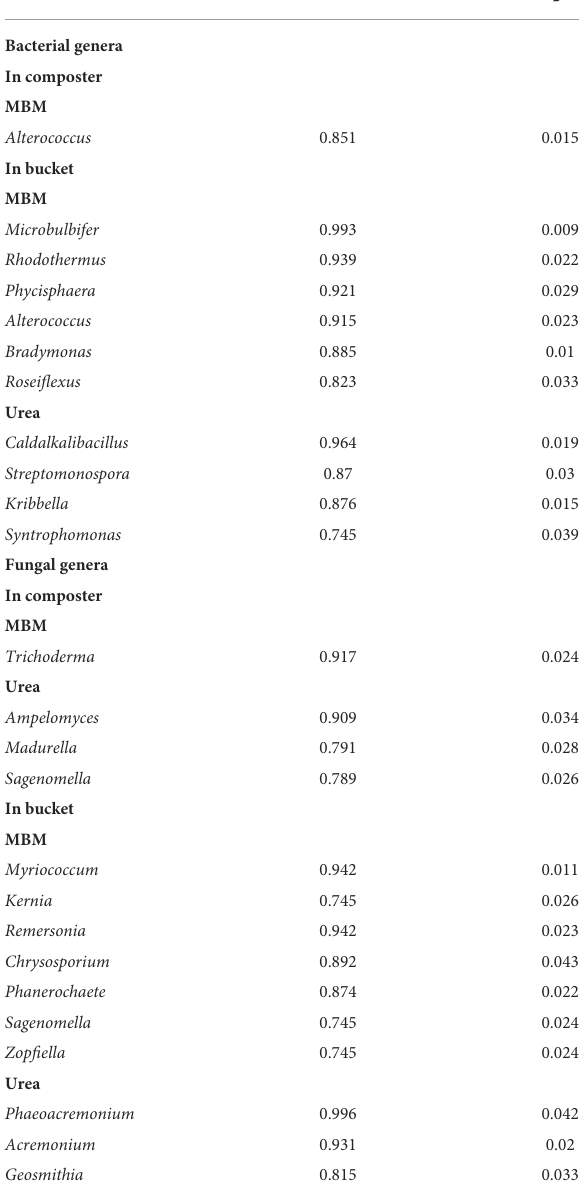
TABLE 1 Bacterial and fungal indicator genera in composters or